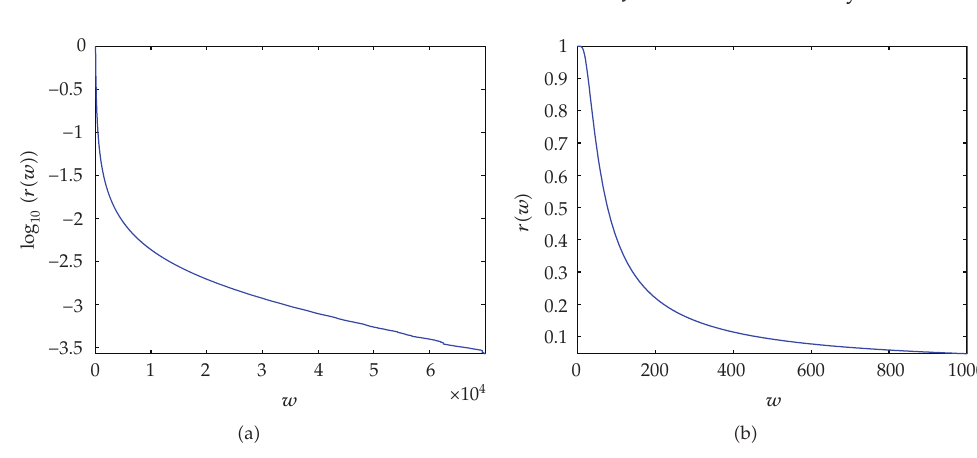
(cid:3) r (cid:3) w (cid:4)(cid:4) for w ≤ 70000; (cid:3) b (cid:4) r (cid:3) w (cid:4) for w ≤ Figure 1: (cid:3) a (cid:4) log 10